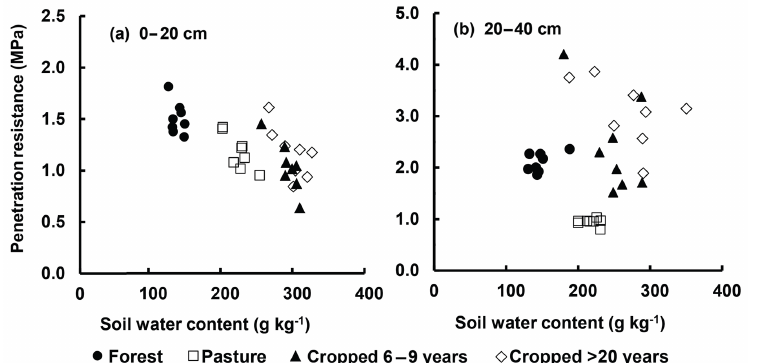
Figure 3. Functional relationships between soil penetration resistance and gravimetric water content for different land uses at two depths ( a 0–20cm; b